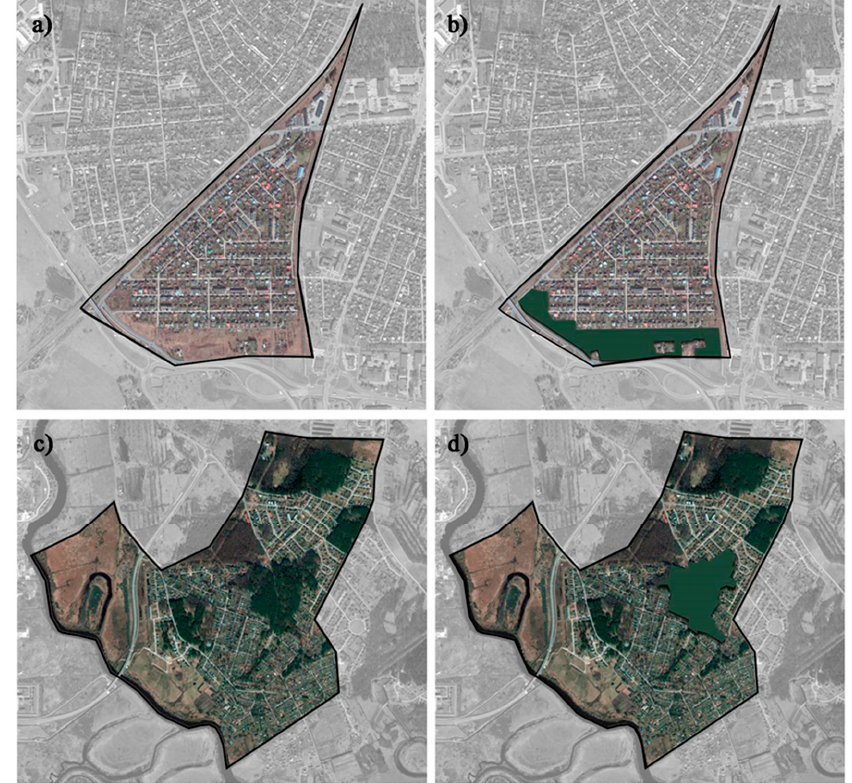
Figure 6. Proposal for new green infrastructure using the “Tartu Linna Üldplaneering”, a general plan for 2030. ( a ) Variku before; ( b ) Variku after; ( c ) Ihaste before; ( d ) Ihaste after. (Source: Satellite image from Google Earth).